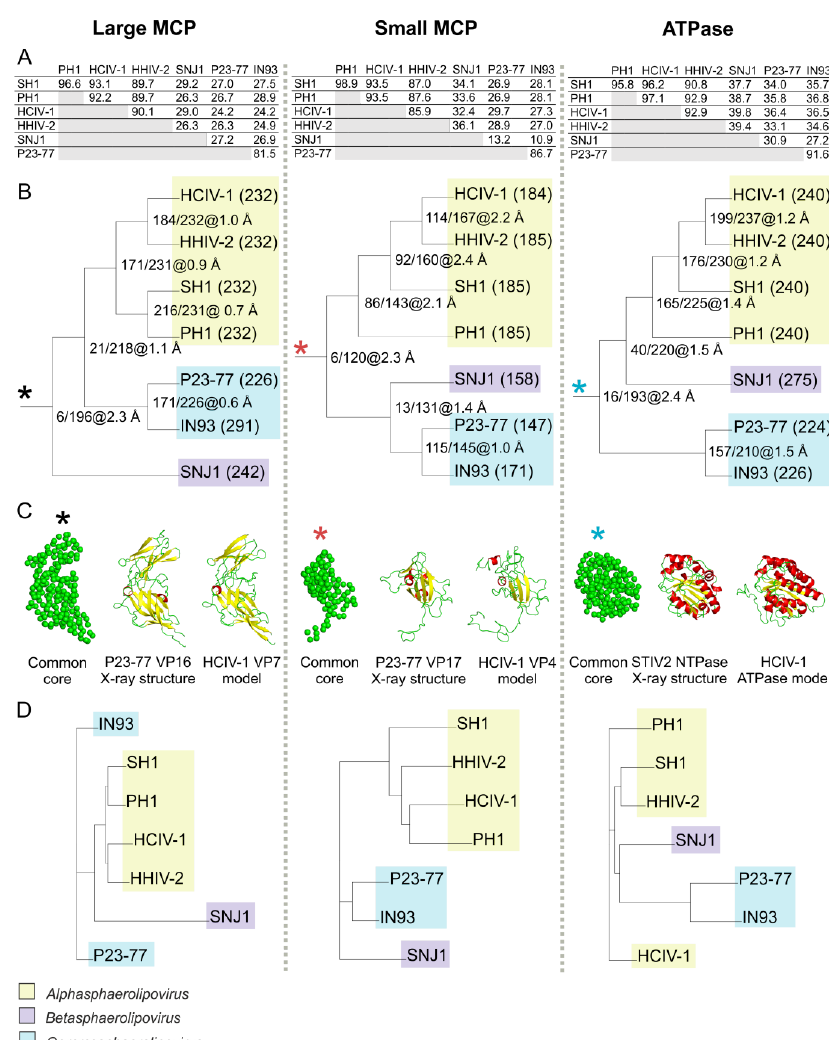
Figure 5. Structural phylogeny based on the predicted structural models of the large MCPs (left), small MCPs (middle), and putative packaging ATPases (right) of the viruses in the family Sphaerolipoviridae . ( A ) Amino acid similarities (%) between proteins calculated with EMBOSS Needle [64]; ( B ) The clustering based on structural models generated by Iterative Threading ASSEmbly Refinement (I-TASSER) sequence-based predictions [62]. Each protein was compared against the corresponding common core (asterisks). Brackets: the number of amino acid residues used in comparisons. Tree node labels: MMM/NNN@X.Y Å, where MMM = number of identical residues at equivalent positions, NNN = total number of equivalent residues in the common core for all proteins in the subtree below that node, and X.Y Å = average root-mean-square deviation (rmsd) of atomic positions over all equivalent (structurally aligned) residues; ( C ) The average α -carbon positions of the common cores (asterisks) with equivalent residues depicted in green; the initial structural templates used: X-ray structures of Thermus phage P23-77 VP17 (PDB ID: 3ZMN) and VP16 (PDB ID: 3ZN4), and Sulfolobus virus STIV2 NTPase (PDB ID: 4KFR); models of the HCIV-1 MCPs (VP7 and VP4) and putative packaging ATPase, as examples. Yellow: β -sheets; red: α -helices; green: loops. Visualized with the PyMOL Molecular Graphics System, Version 1.8 Schrödinger, LLC; ( D ) Phylogenic trees of the protein models based on their common cores and including only equivalent residues (Homologous Structure Finder (HSF) Program) [63]. Branch lengths are calculated as in [63]. The trees were visualized with Dendroscope [65]. For methodological details, see